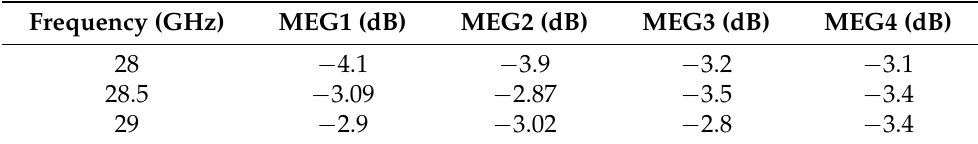
Table 1. Calculated mean effective gain (MEG) values of the MIMO